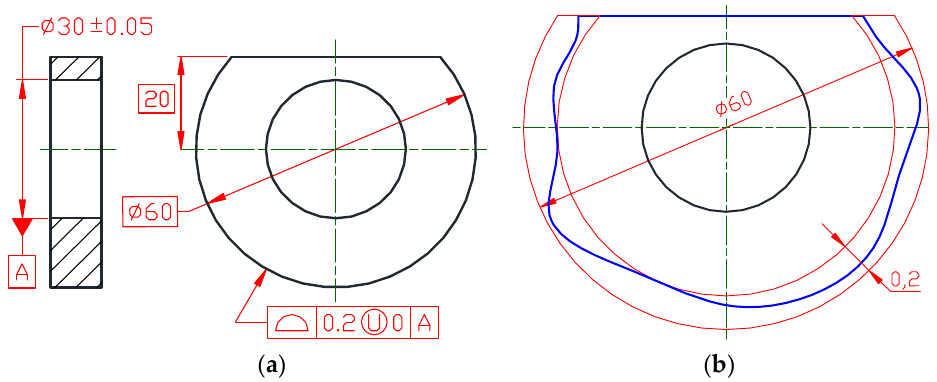
Figure 19. ( a ) The surface profile tolerance with modifier (ASME Y14.5); ( b ) meaning—0 mm outside the theoretically exact feature implies that the whole tolerance zone is inside the maximum material boundary.